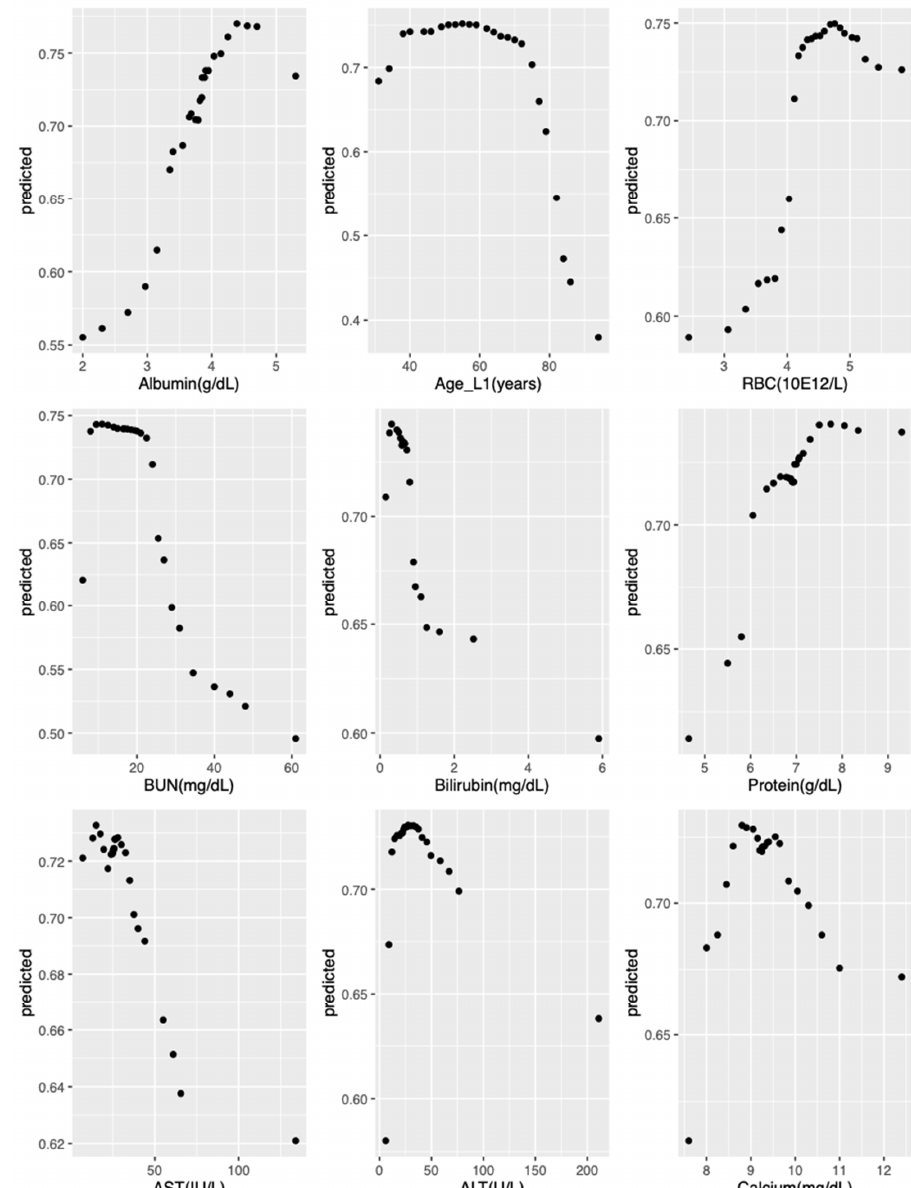
Figure 5. Partial-dependence plot for the top nine variables in the RSF model applied to curated + labs dataset. Vertical axis shows predicted five-year survival probability. RSF: random survival forest; L1: time of initiation of first-line therapy; RBC: erythrocytes: BUN: urea nitrogen; AST: aspartate aminotransferase; ALT: alanine aminotransferase.